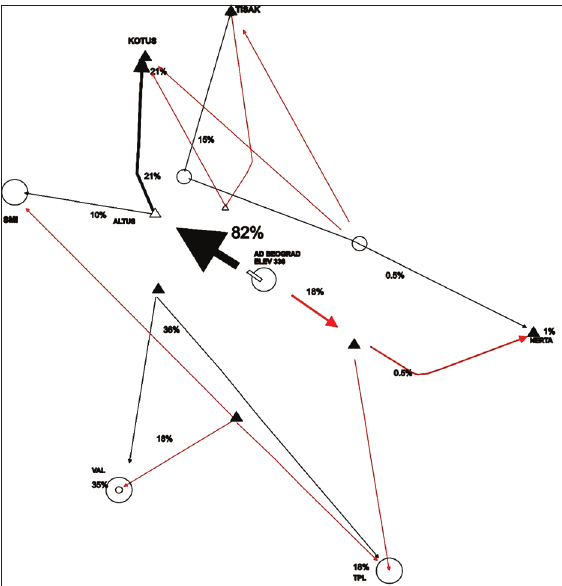
Fig. 6. Departure routes at RWY 12 (red line) and RWY 30 (black line) with percentage of arrival route use